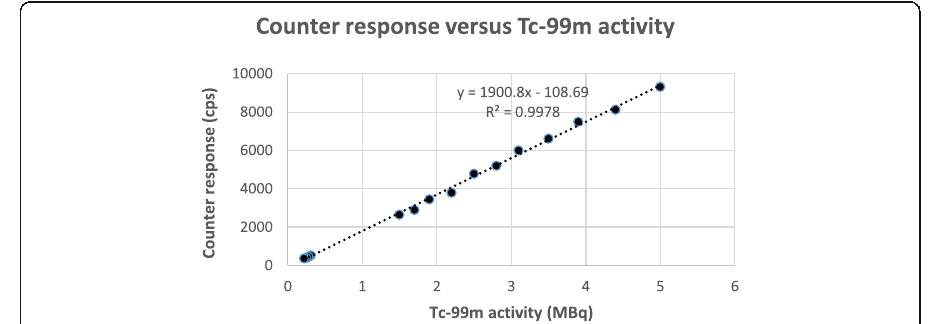
Fig. 2 Response of the counter for Tc-99m